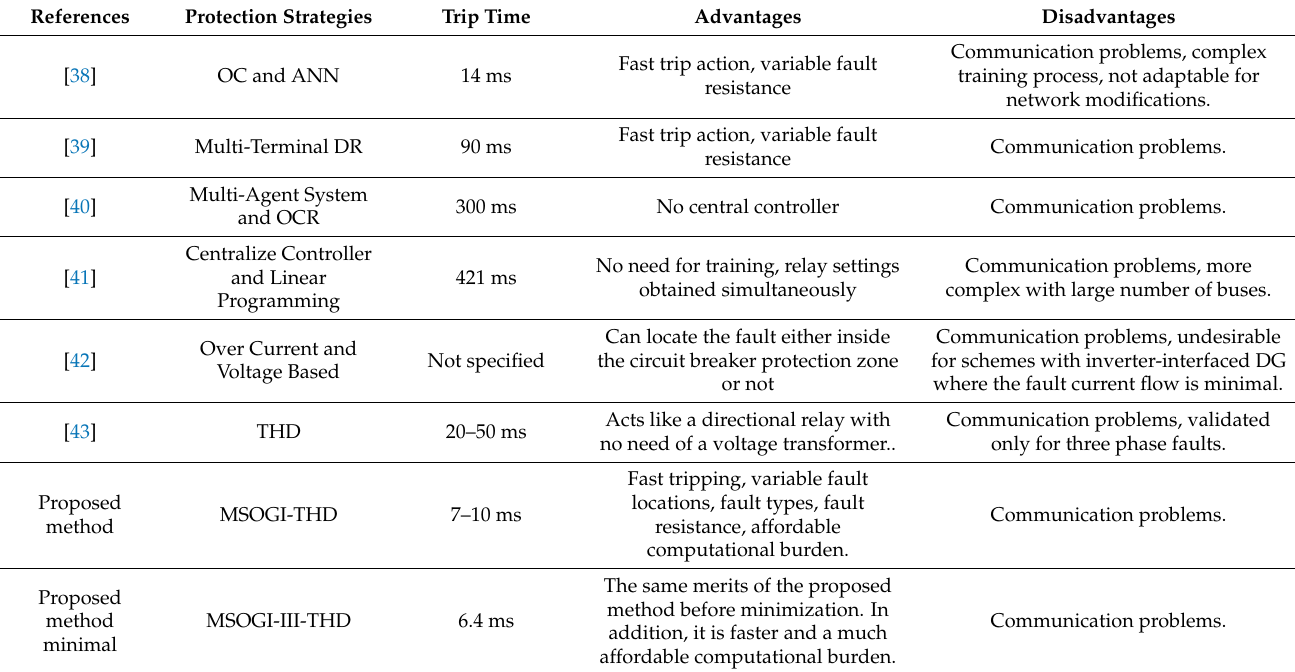
Figure 15. Trip signals of the MSOGI-THD and DR protection methods during symmetrical and unsymmetrical faults with different fault resistance. Table 4. Comparison of the proposed method with other methods operating under similar condi- tions.